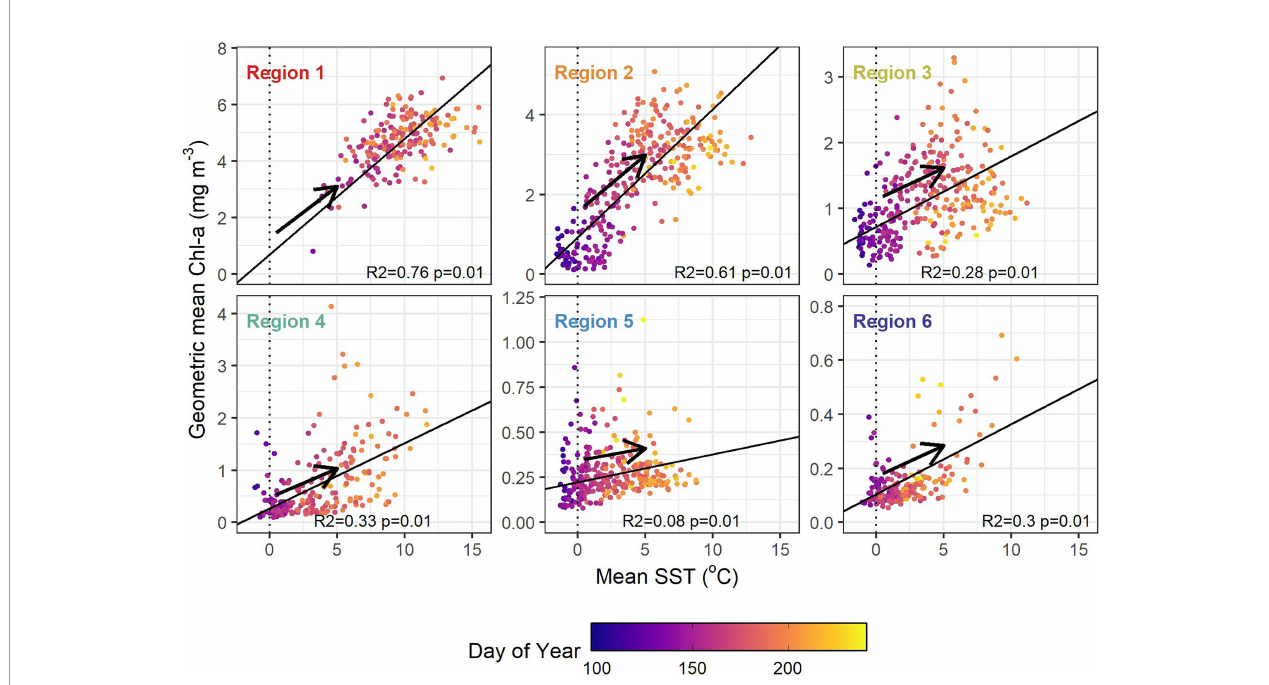
FIGURE 8 | Chl-a and SST regression for time series values from annual warming (dates preceding the maximum annual SST value for all years). Points are coloured by the day of year, with arrows indicating the general temporal